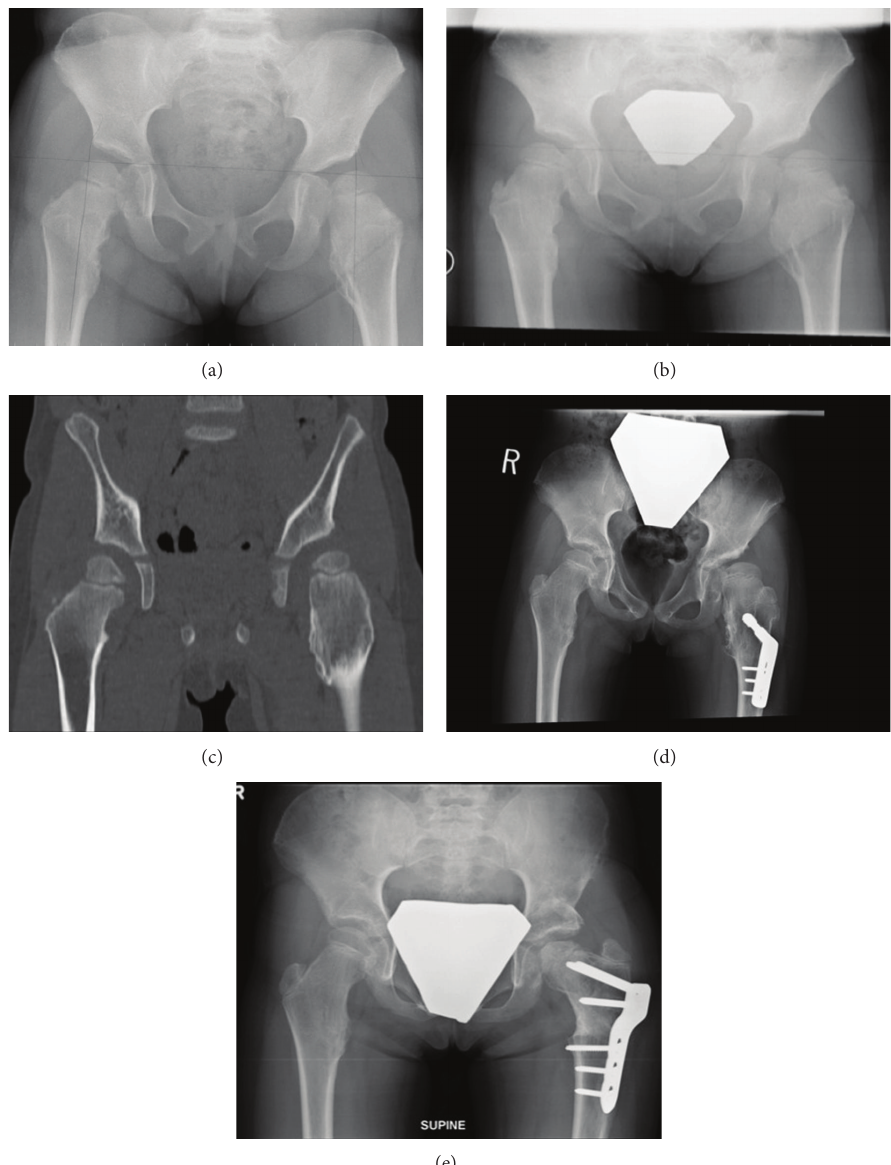
Figure 2: (a) Anteroposterior pelvic radiograph at initial presentation. (b) Anteroposterior pelvic radiograph and (c) Computed tomography of the pelvis at one-year follow-up. (d) Anteroposterior pelvic radiograph 4 years after left femoral varus derotational osteotomy (VDRO) with partial excision of the osteochondroma. (e) Anteroposterior pelvic radiograph ten months after performing the second VDRO, modified Dega osteotomy, and extensive excision of femoral neck osteochondroma. Partial left femoral head necrosis is also